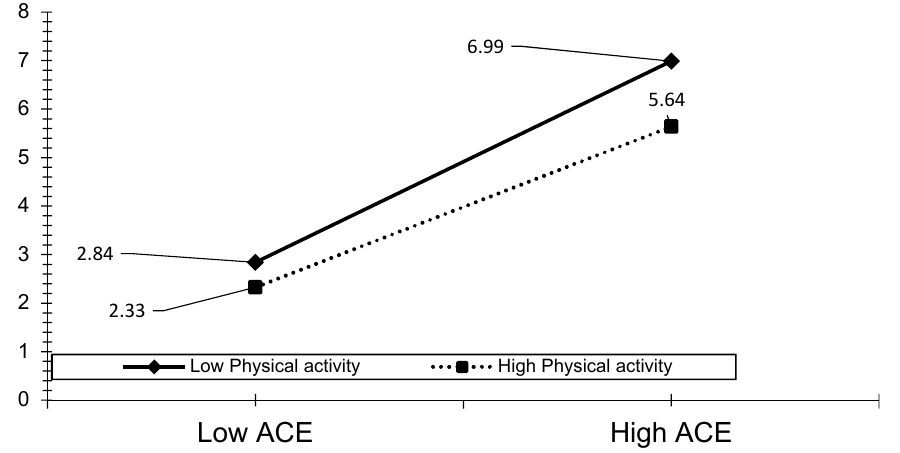
Figure 4. Model 5—Graph of interaction effect between PA and child abuse on physically unhealthy days.